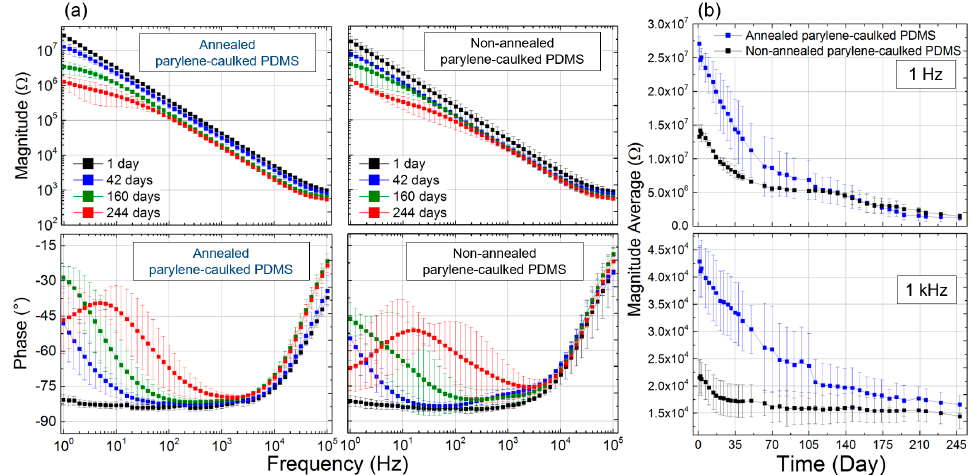
Figure 4. ( a ) Electrochemical impedance spectroscopy of the electrodes based on annealed and non-annealed parylene-caulked PDMS at day 1 to 244; and ( b ) temporal changes in impedance magnitude of the electrodes at 1 Hz and 1 kHz.